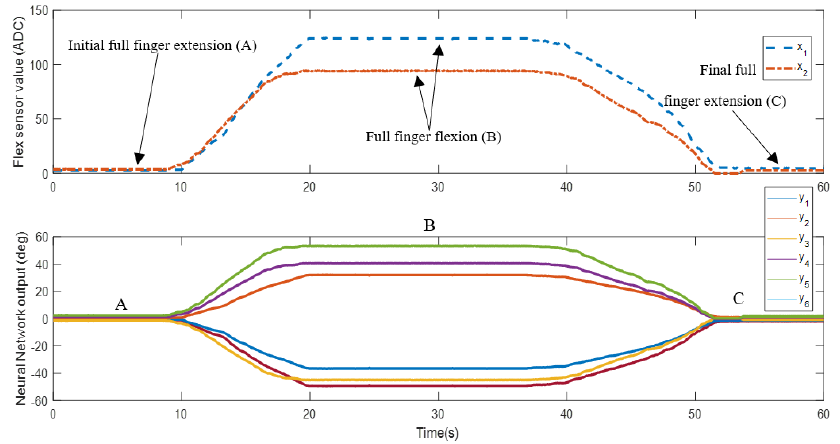
Figure 10. neural network regression input and output.